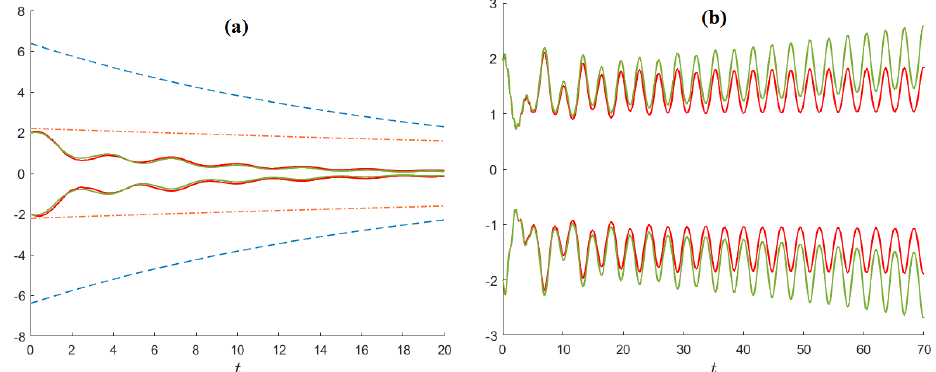
s cos 2 ( 3 s )) , and ϕ 2 ( s ) = 2 ( 1 + 3 (cid:107) e − η ( t − t 0 ) , the orange dash-dotted lines 0